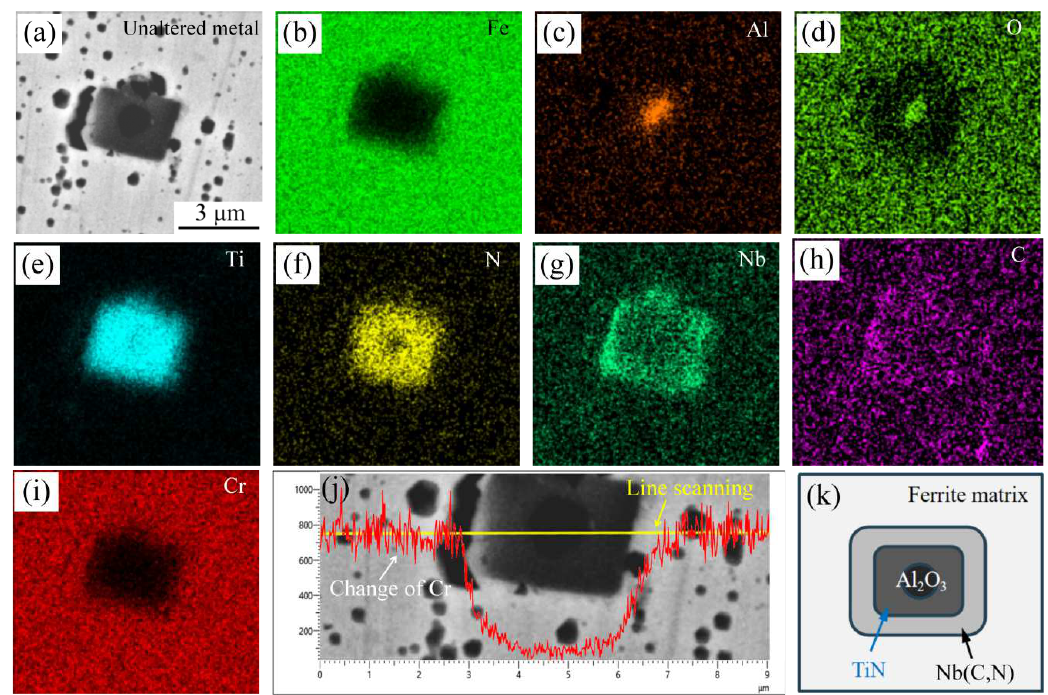
Figure 5. Morphology, structure, and element distribution of inclusion in a steel-3 matrix (unaltered metal): ( a ) Al 2 O 3 -TiN- Nb(C,N) composite inclusion in ferrite matrix before HTUC, ( b – i ) area scanning of the inclusion by using EDS, ( j ) line scanning by using EDS to show the Cr distribution, and ( k ) schematic diagram of composite inclusion.